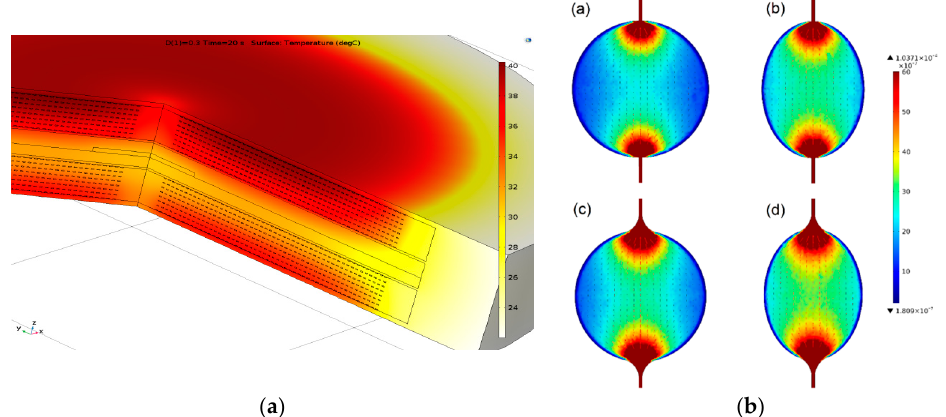
Figure 2. Simulations for heat transfer showing the contribution of the set of coils to the rising temperature of the microfluidic reservoir after 20 s ( a ); the fluid flow homogeneity relative to the reservoir shape ( b ).